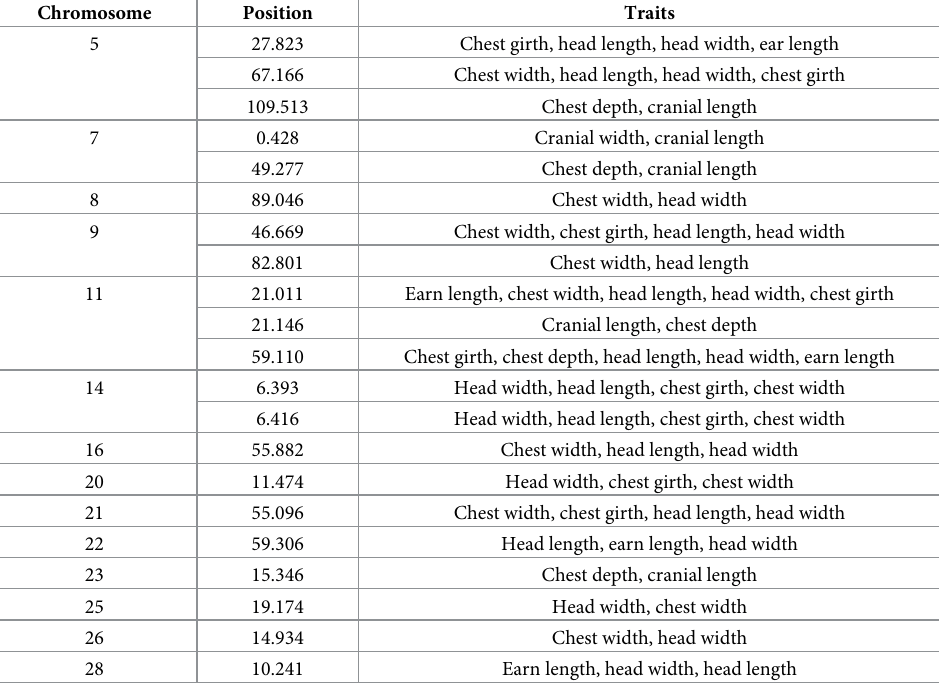
Table 6. Overlapping regions identified for quantitative trait GWAS